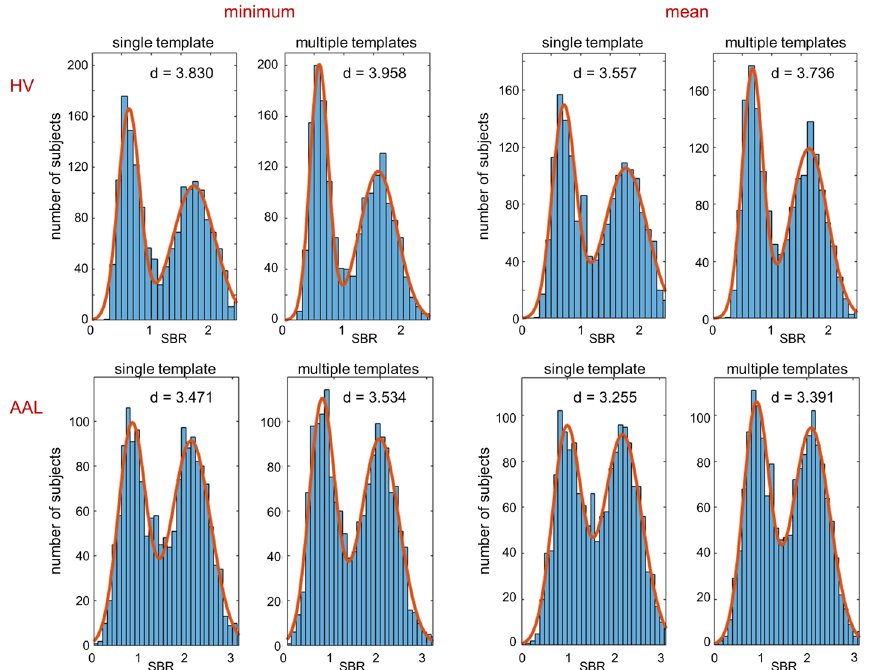
Fig. 2 Histograms of the putamen SBR. The histograms represent the 1702 DAT-SPECT with proper stereotactical normalization according to visual inspection, separately for the different settings. The fit by the sum of two Gaussians is indicated by a continuous line. The effect size d of the distance between the two Gaussian functions was computed according to Eq.